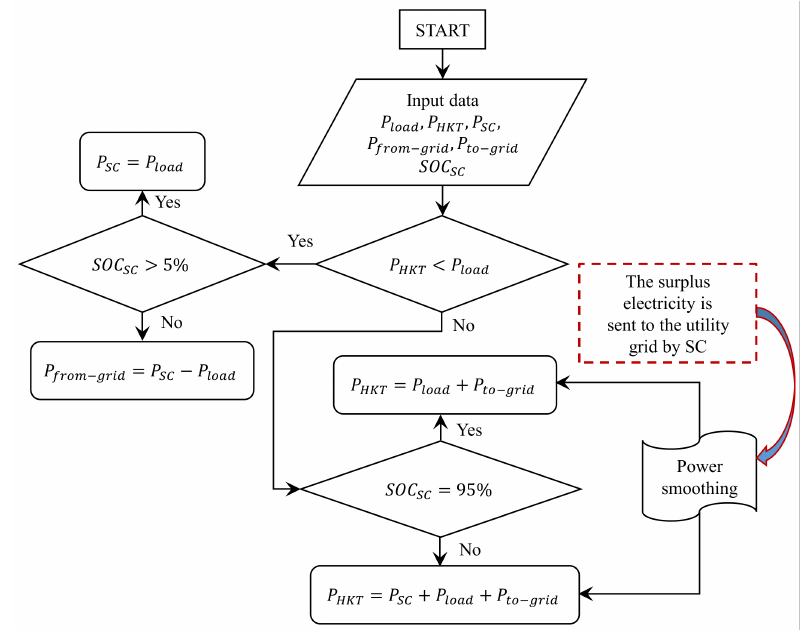
Figure 6. Explanatory algorithm of the proposed energy